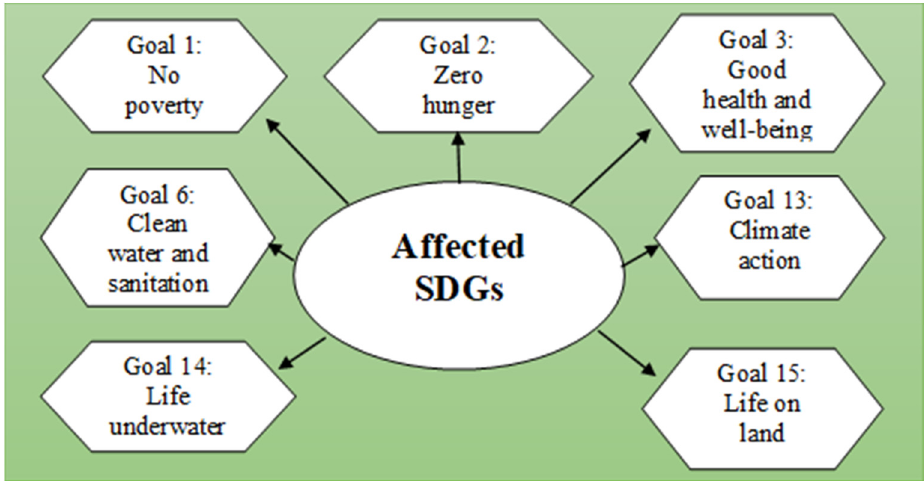
Figure 5. SDGs that are likely to be directly affected by mining in the Atiwa Forest Reserve.